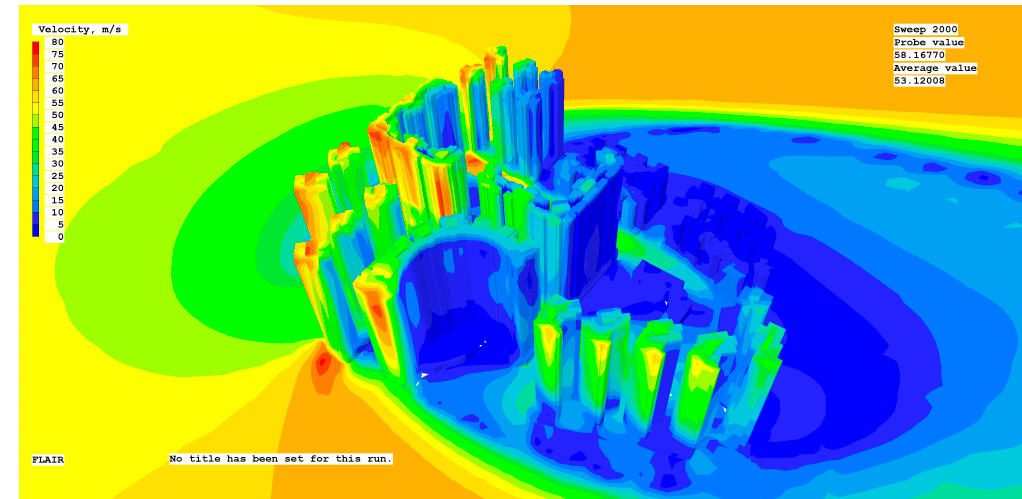
Int. J. Environ. Res. Public Health 2023 , 20 , 4143 Figure A13. The La Marina and the Residencia Macau look south. Figure A13. The La Marina and the Residencia Macau look south.